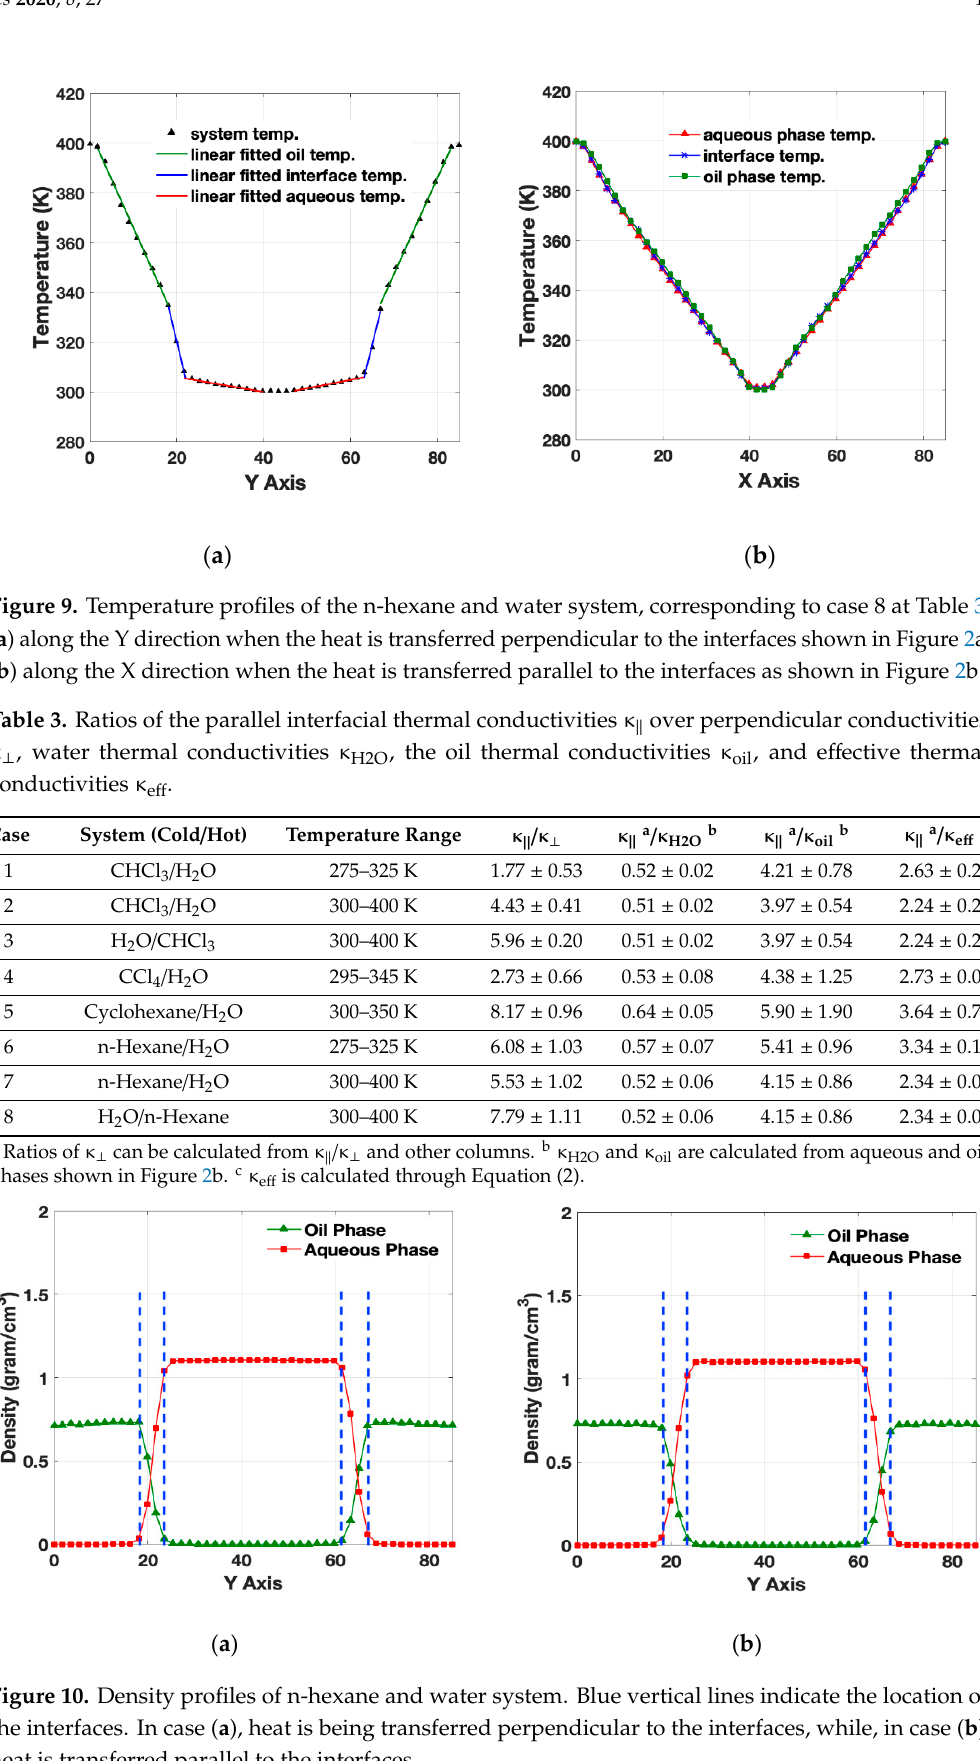
Table 3. Ratios of the parallel interfacial thermal conductivities κ || over perpendicular conductivities κ ⊥ , water thermal conductivities κ H2O , the oil thermal conductivities κ oil , and effective thermal conductivities κ eff . Case